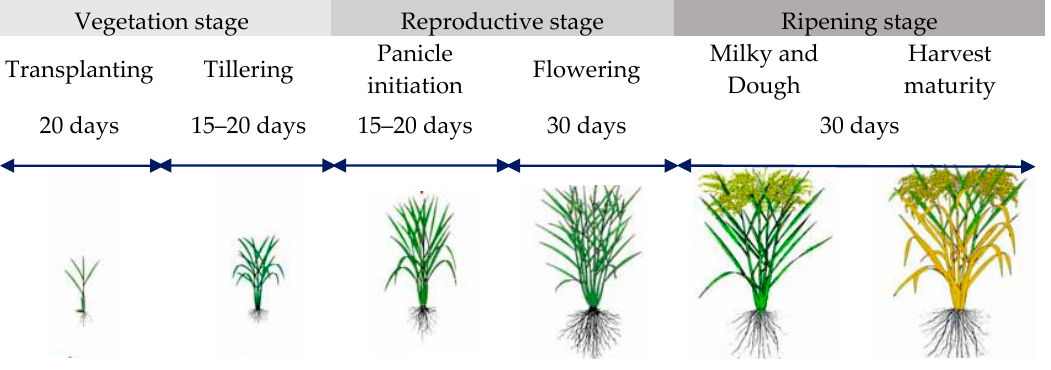
Table 2. Cultivar-specific parameters input into the AquaCrop model.